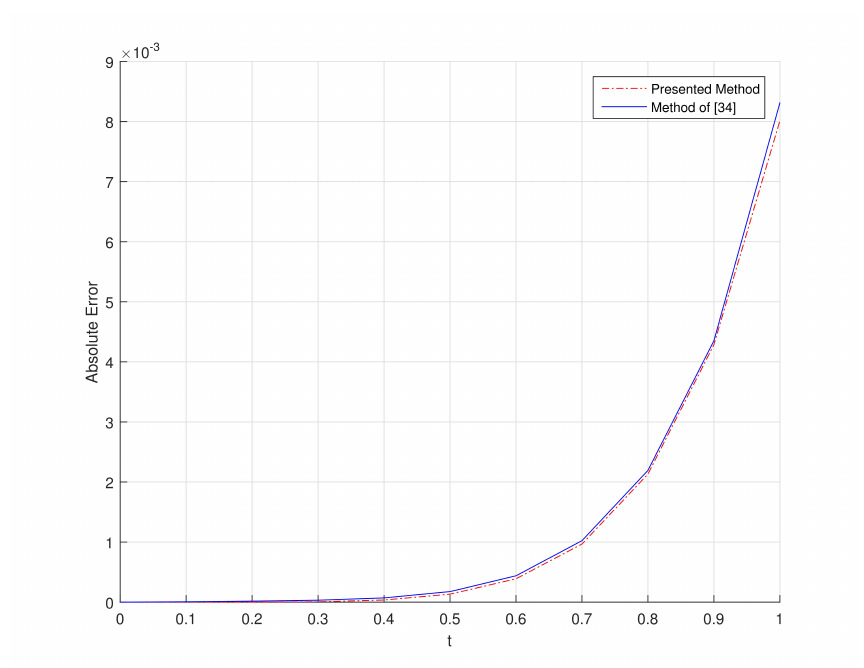
Figure 9. The behaviour of absolute errors obtained by using proposed method and the method of [54].